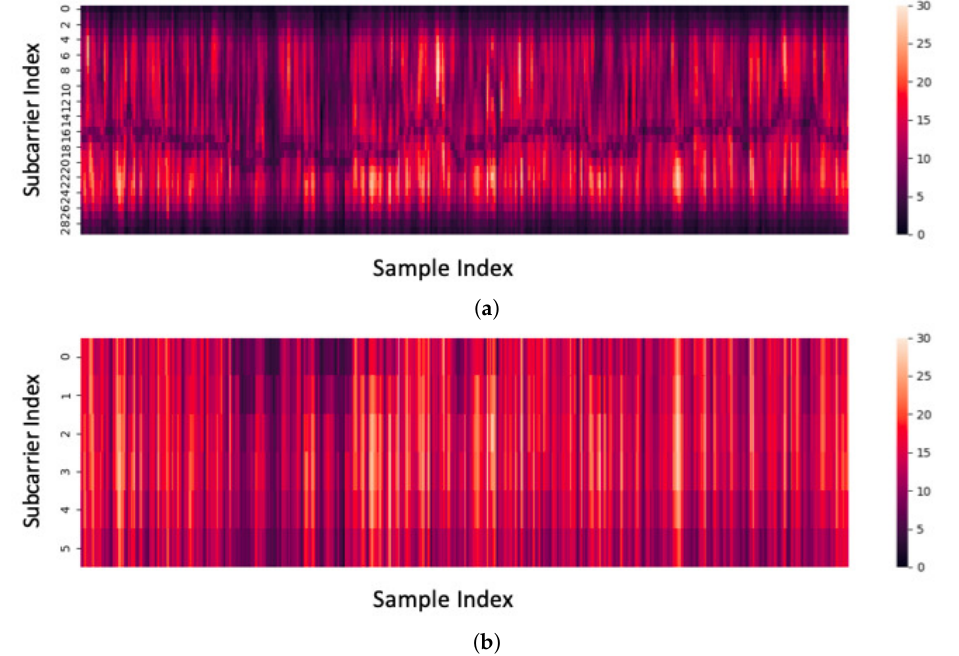
Figure 7. Sensitive subcarrier extraction: ( a ) amplitude of all subcarriers, and ( b ) amplitude of k most sensitive subcarriers ( k =